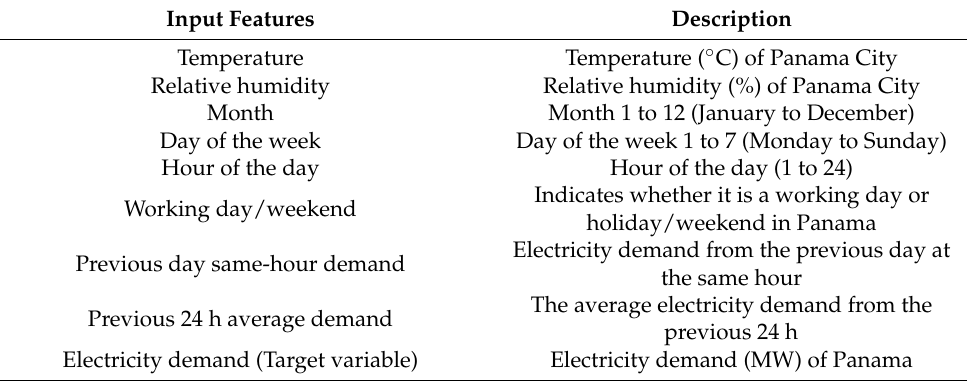
Table 2. Feature Table 2. Feature Selection.